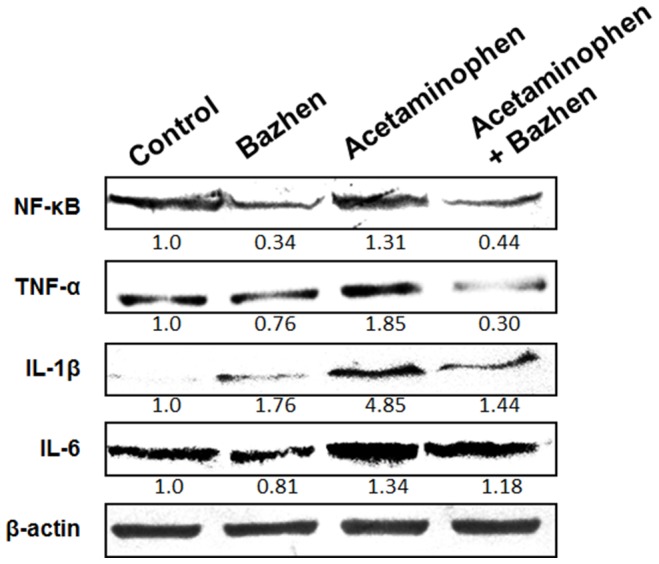
Effects of Bazhen decoction on the hepatic NF-κB, TNF-α, IL-6 and IL-1β expressions in mice intoxicated with acetaminophen.Data were normalized to β-actin used as control.